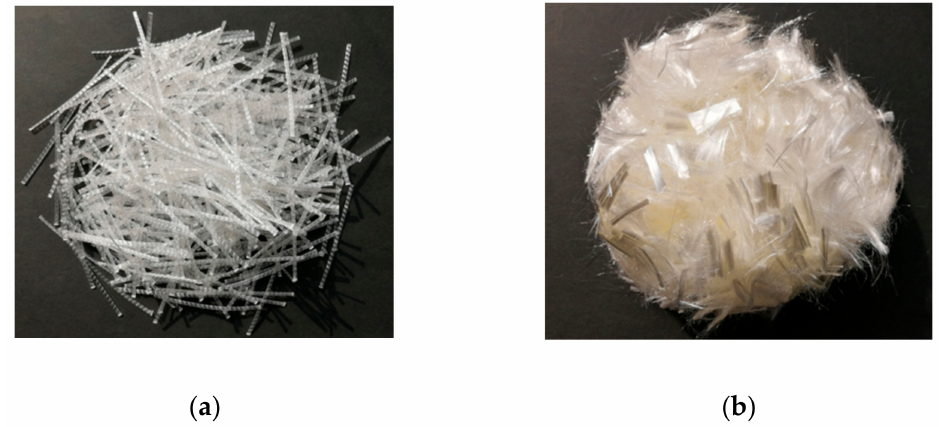
Figure 2. Appearance of fibers: ( a ) FSTF; ( b ) PVAF.